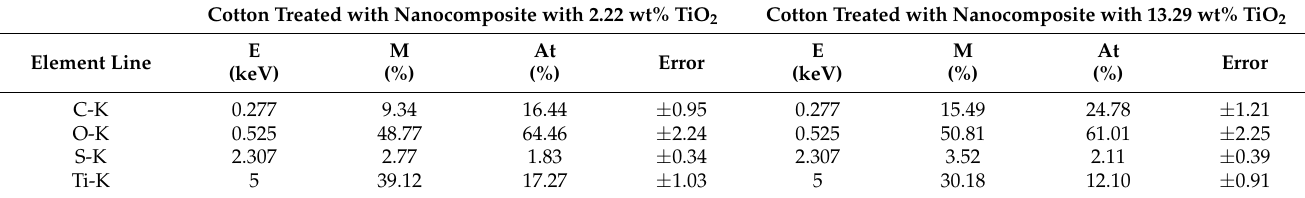
Table 6. EDS analysis of nanocomposite-treated cotton fabric.